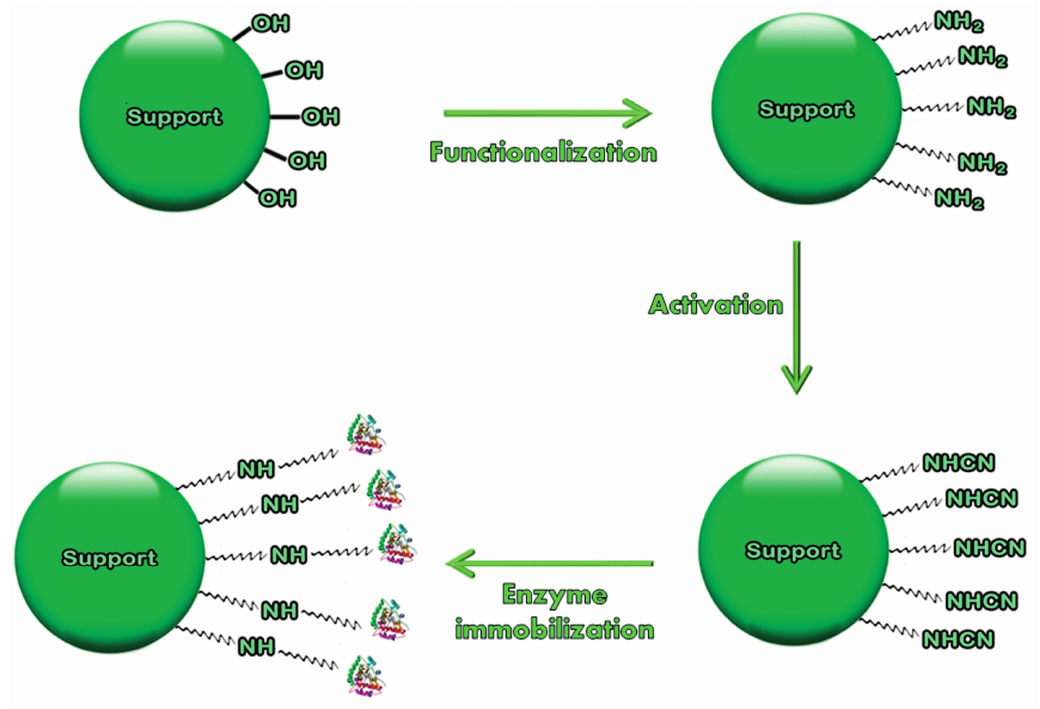
Figure 1. Scheme of functionalization and activation of inorganic supports during covalent immobilization (functionalization with –NH is reported as an